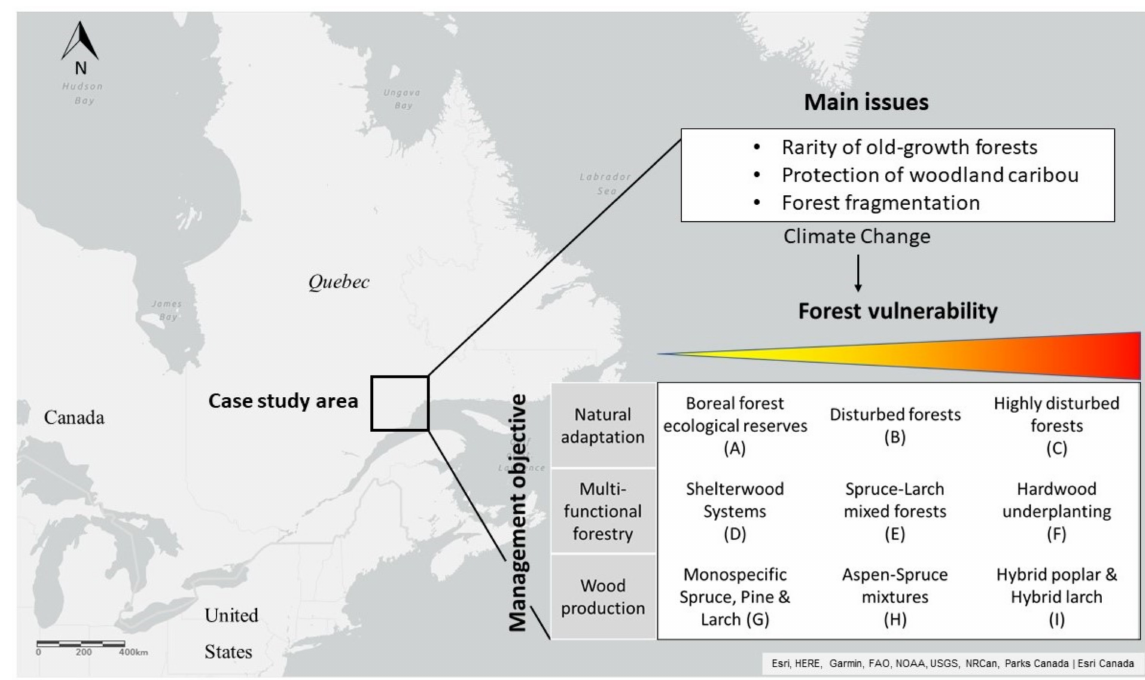
Figure 2. Location of the theoretical case study area in Qu é bec (Canada) with the three main forest management issues and an overview of the suggested portfolio of nine adaptation